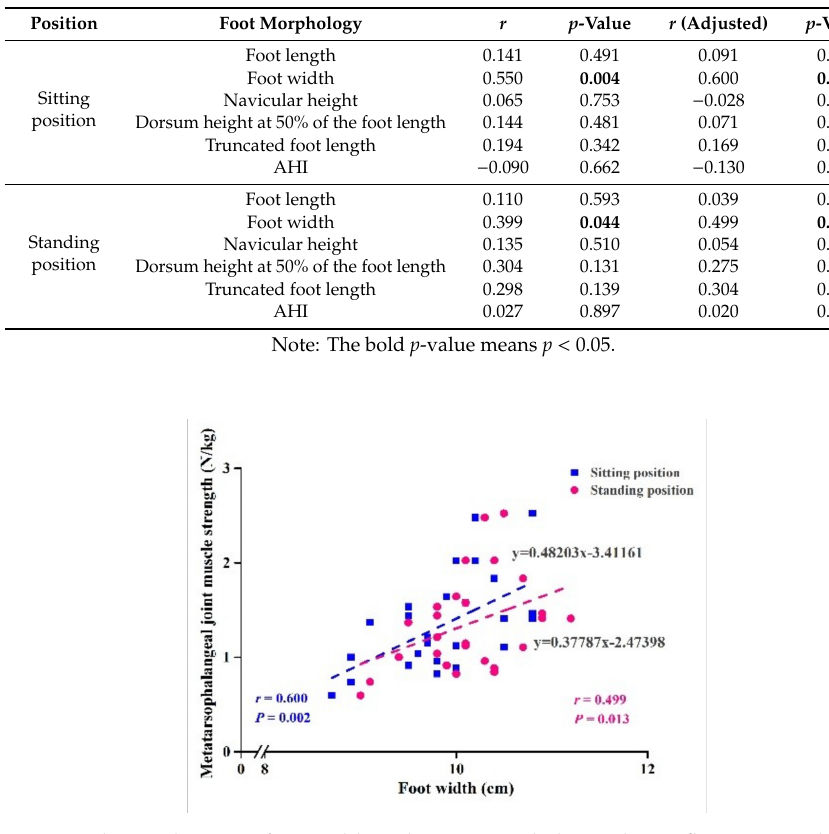
Figure 4. Correlations between foot width and metatarsophalangeal joint flexor strength adjusted to age and BMI in sitting and standing